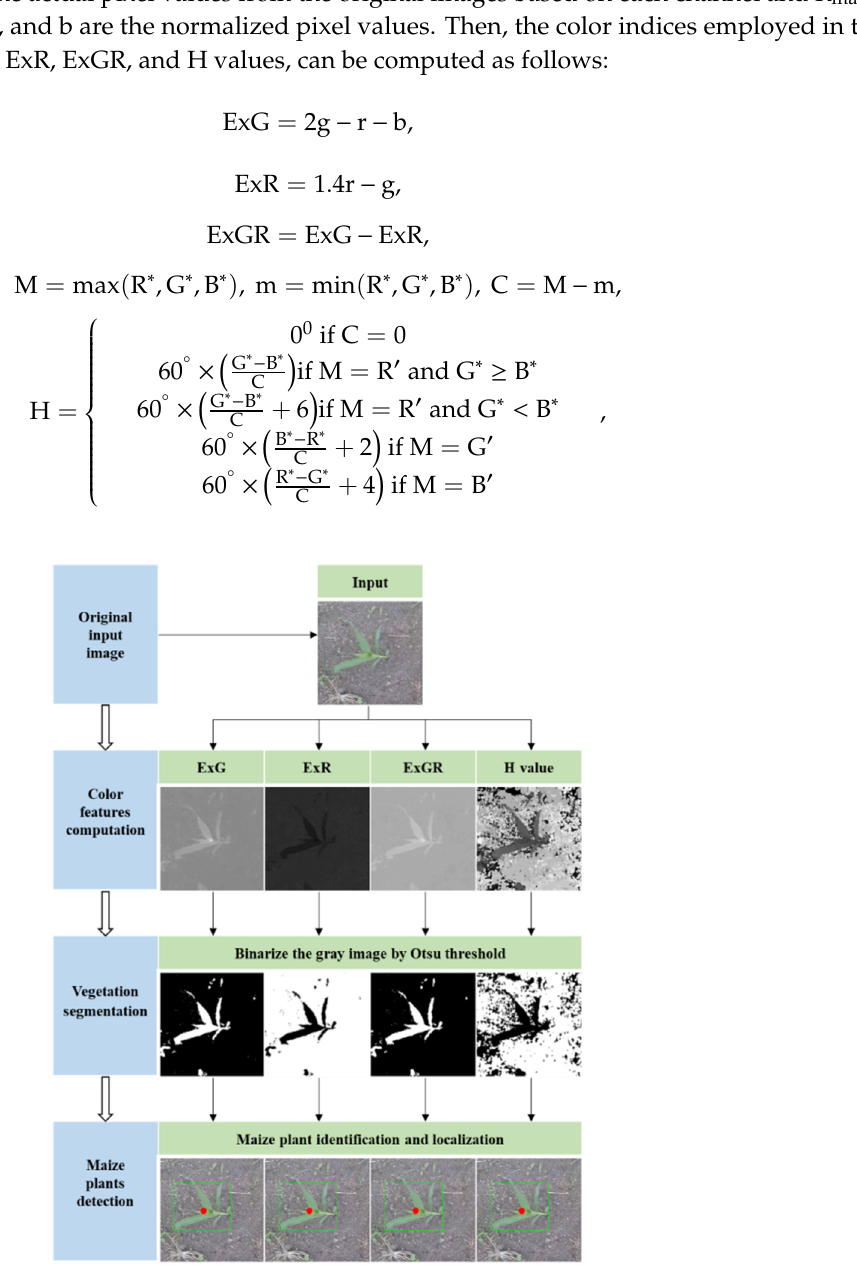
Figure 1. General workflow of color feature–based methods.